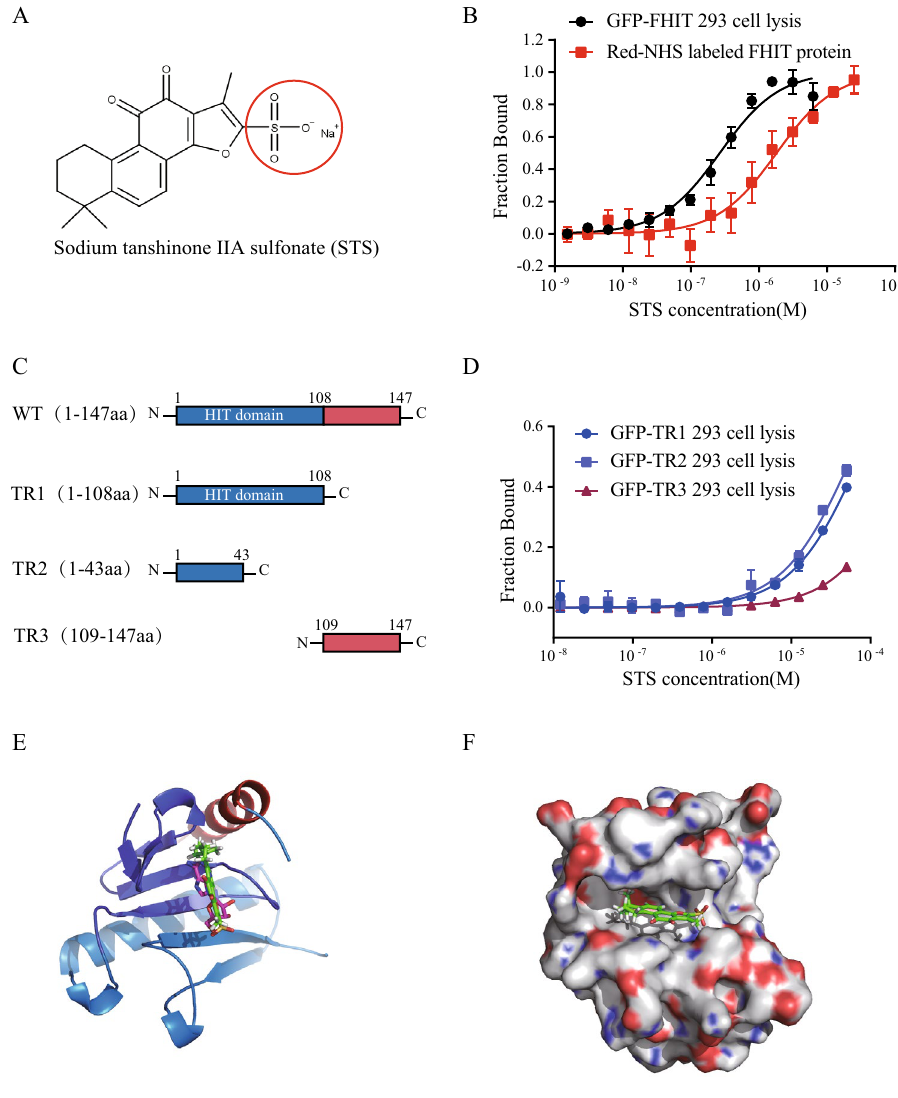
Figure 2. STS directly binds to FHIT protein. ( A ) Chemical structure of STS. ( B ) Cellular MST assay of the interaction between STS and FHIT. HEK293T cell lysate containing GFP tagged FHIT (black circle) or Red- NHS labeled FHIT (red square) were incubated with STS. The Kd value is 268.4 ± 42.59 nM and 1.82 ± 0.3 µM for GFP-FHIT and Red-NHS FHIT, respectively. ( C ) Schematic representation of the full-length FHIT and the truncated mutants used in the MST assay. The N-terminal region (1-108aa) containing the HIT domain is colored by blue, and the C terminal is colored by red. ( D ) MST assay of STS and GFP tagged FHIT truncations, the Kd value is 75.05 µM for TR1 (blue circle), and 58.18 µM for TR2 (blue square). No Kd value was calculated with TR3 (dull-red triangle). ( E ) Representation of molecule docking of FHIT-STS complex by Autodock vina software based on the FHIT-AMP complex (PDB code:3FIT). The region of 1-43aa is shown in mazarine, 44-108aa is shown in wathet, 109-147aa is shown in red. STS is shown in green sticks and AMP is shown in purple sticks. Structure alignment indicated that STS almost occupies the AMP binding site. ( F ) The surface model of the predicated FHIT-STS